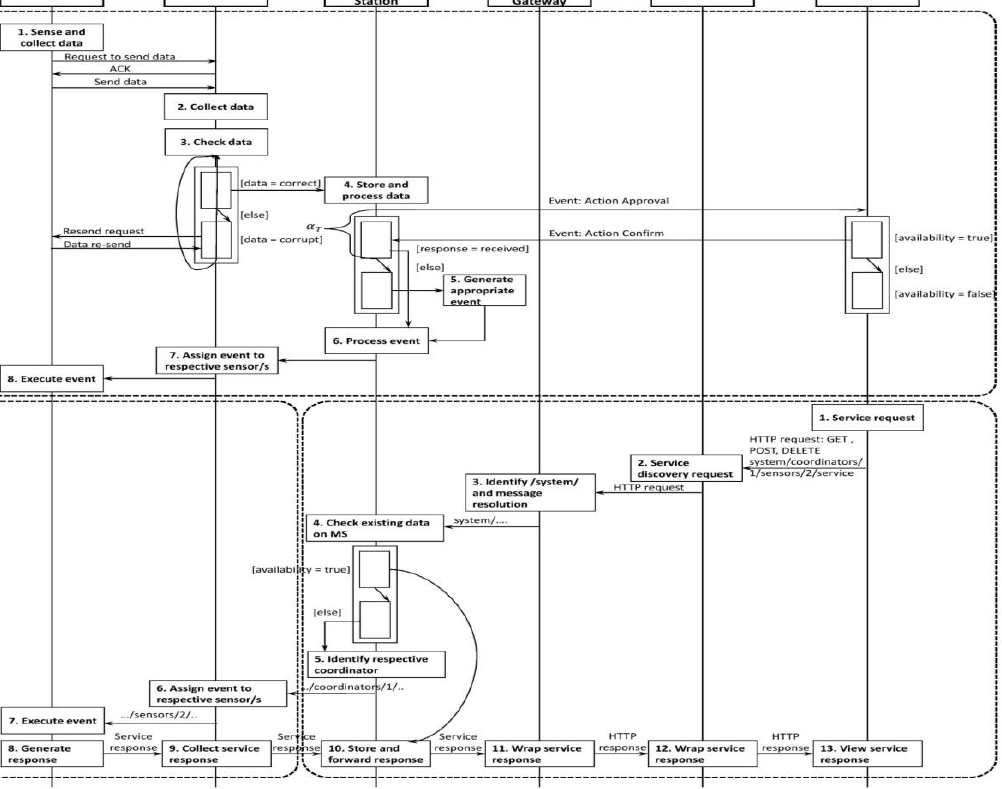
Figure 2. Event management system for in-house controls and remote smart home user controls.